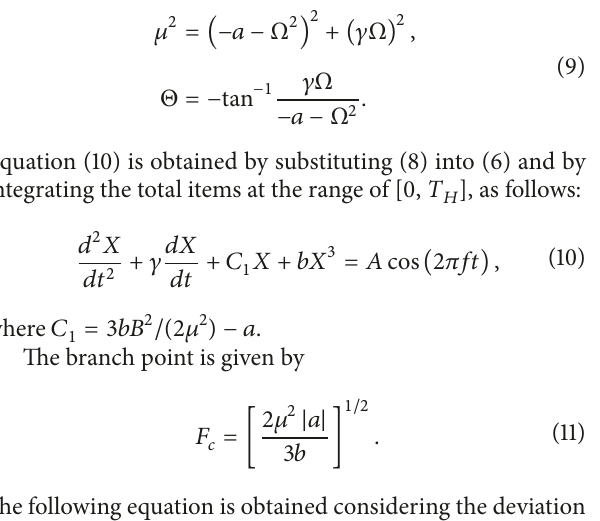
Figure 2: Resonance response